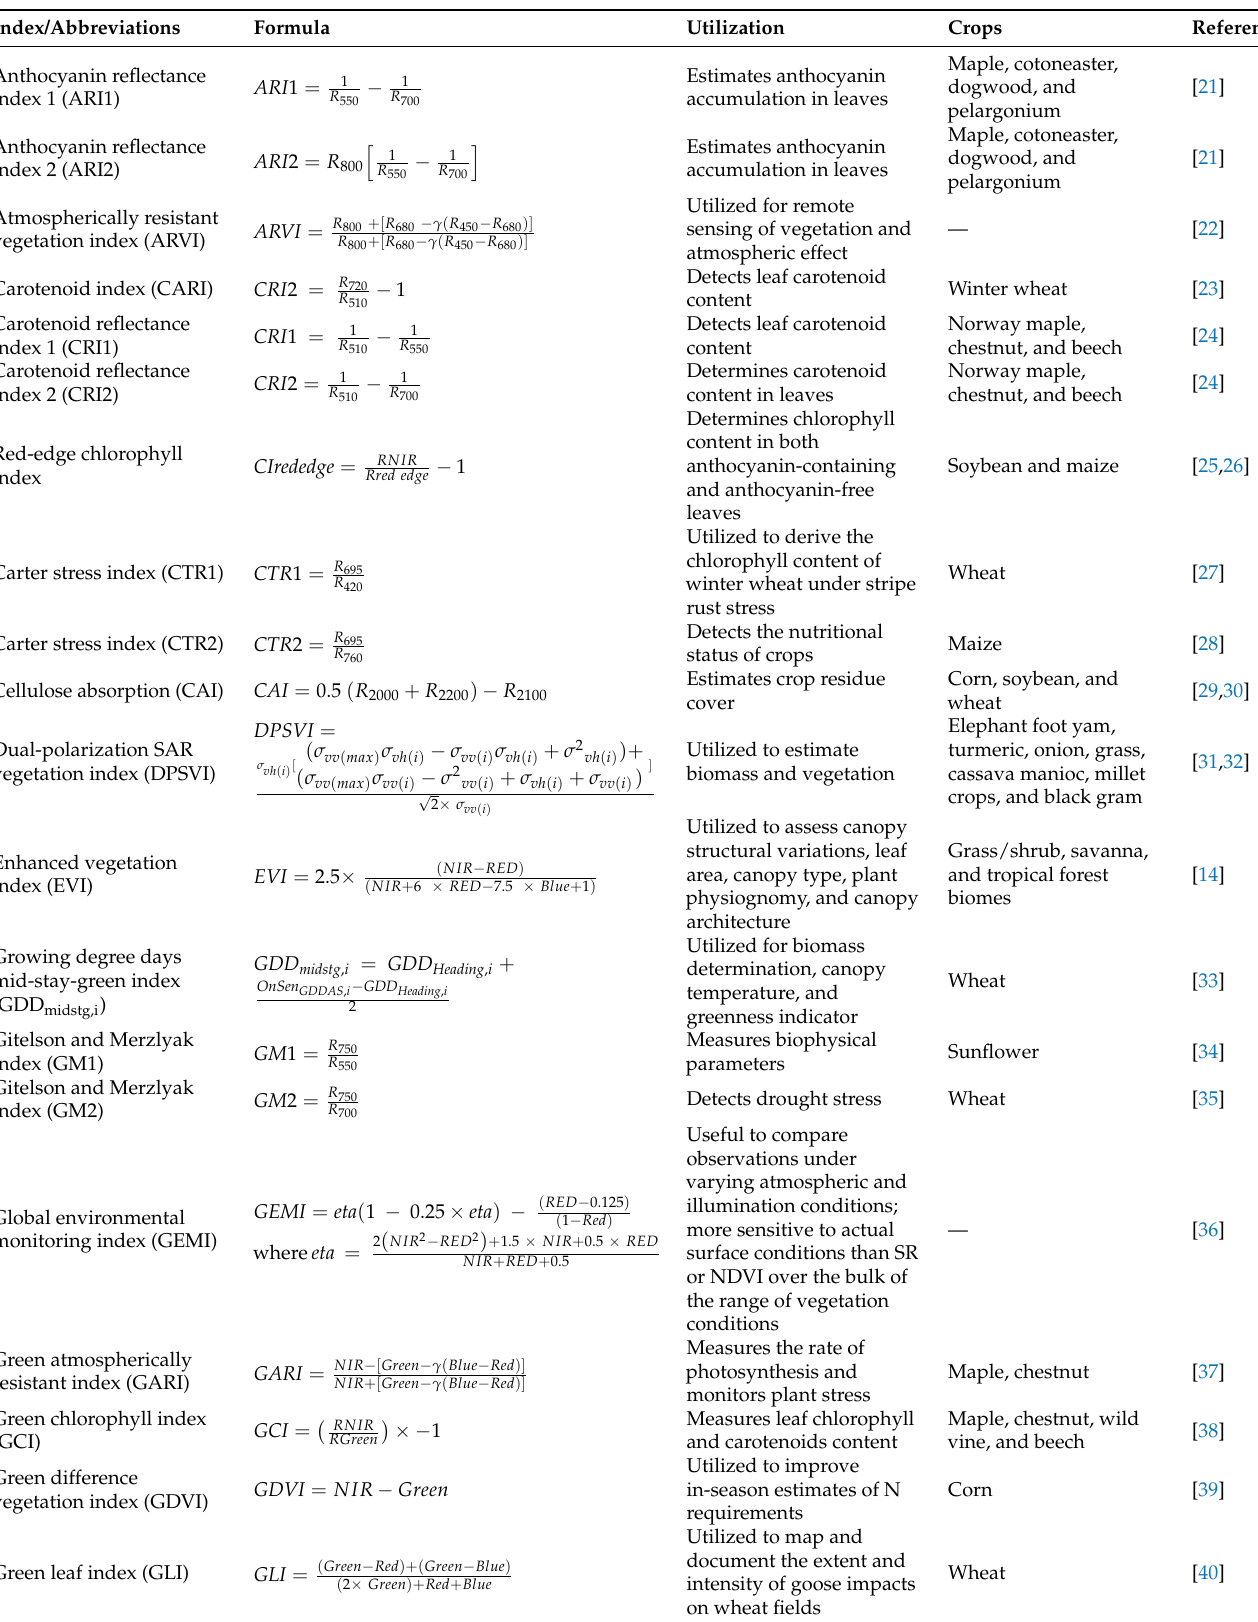
Table 1. Vegetation index types and their equation and utilization in plant